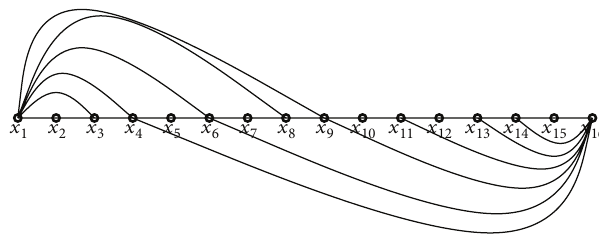
Figure 5: Config-3: a combination of Config-1 and Config-2.